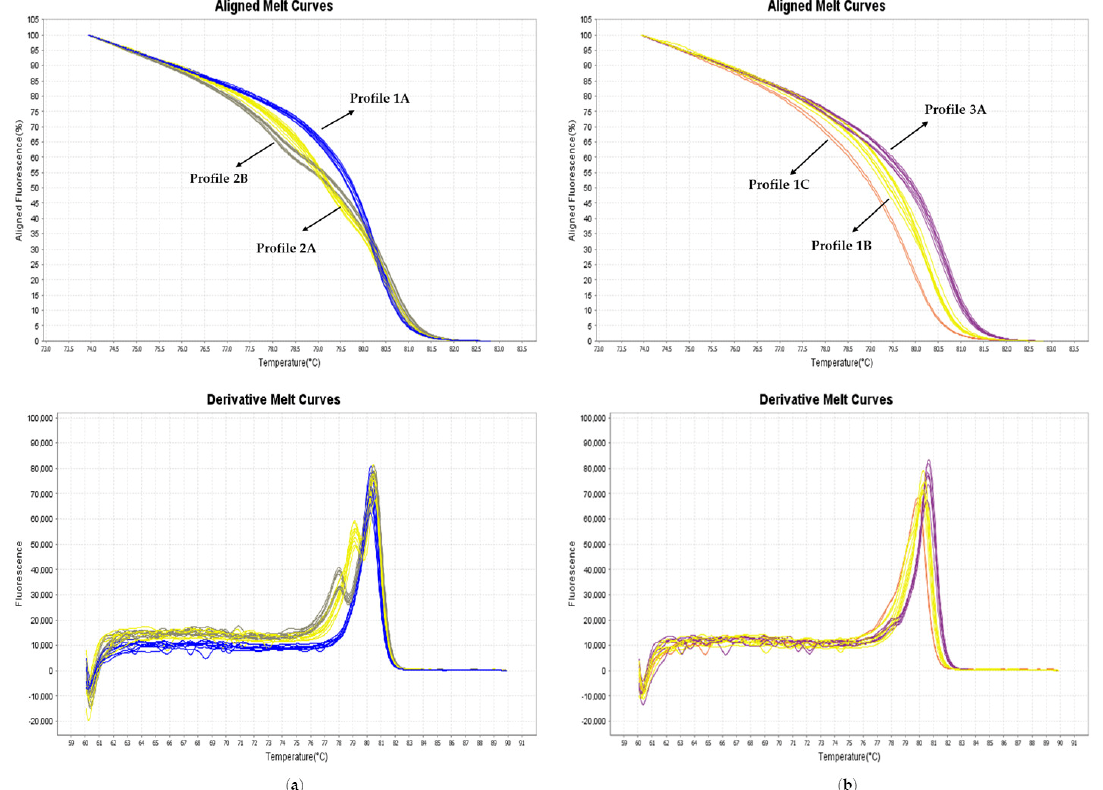
Figure4. Aligned melt curves andderivative meltcurves of41 mandarinaccessions ofCREA Figure 4. Aligned melt curves and derivative melt curves of 41 mandarin accessions of CREA germplasm collection. ( a ) Profile 1A: Clemapo, Fallglo, Foma107, ISA, Kara, Kinnow, Mapo, Okitsu,